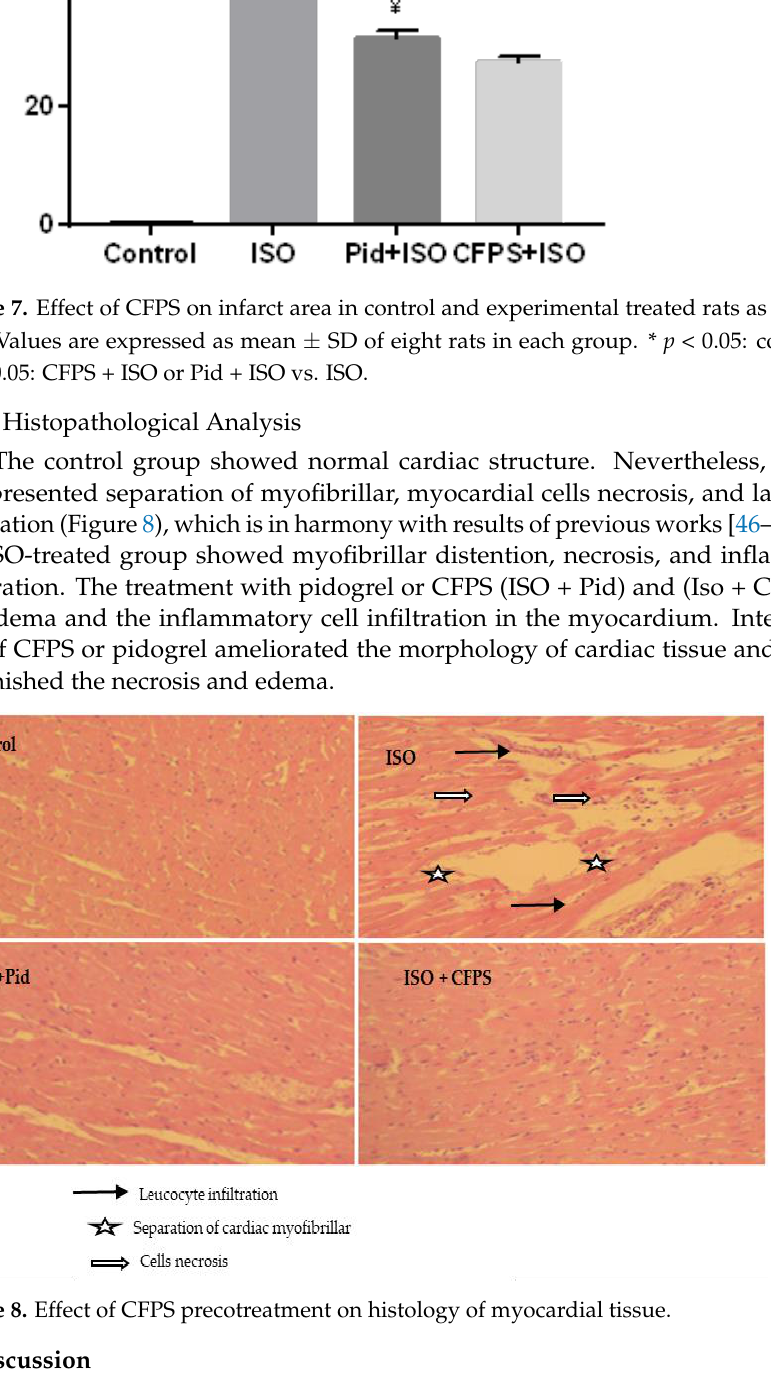
Figure 8. Effect of CFPS precotreatment on histology of myocardial tissue. 4. Discussion In the current study, 6.5% of crude polysaccharides were successfully extracted from the aerial part of Clematis flammula (CFPS) by water extraction and the alcohol precipita- tion method. The recovery yield of polysaccharides obtained in the present work was sim- ilar to that reported for Clematis huchouensis Tamura (6.94%) [22], but higher than that of those extracted from Camellia oleifera (1.8%) [52] and pistachio external hull (4.10%) [53]. However, the obtained yield in the current study was lower than that obtained by Fan et al. [54] for acidic polysaccharides from Citrus grandis . The observed differences could be